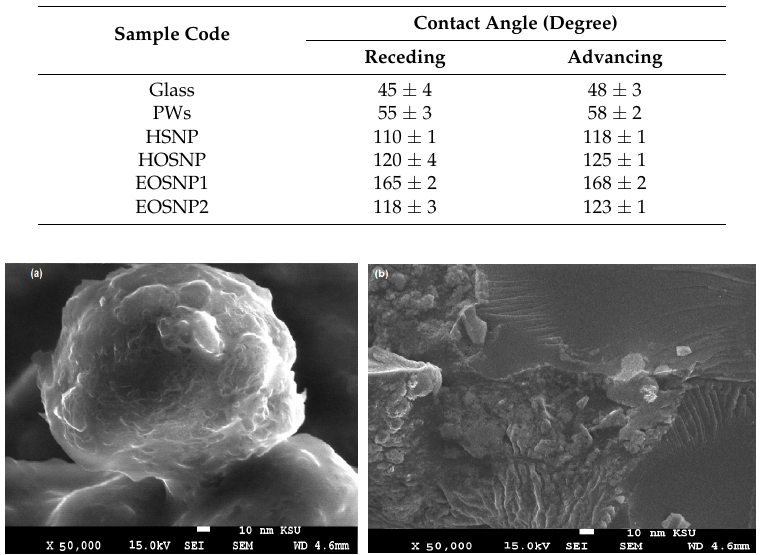
Table 3. Contact angle of the water droplet on the hydrophobic SNP microcapsule films, at 25 ◦ C.